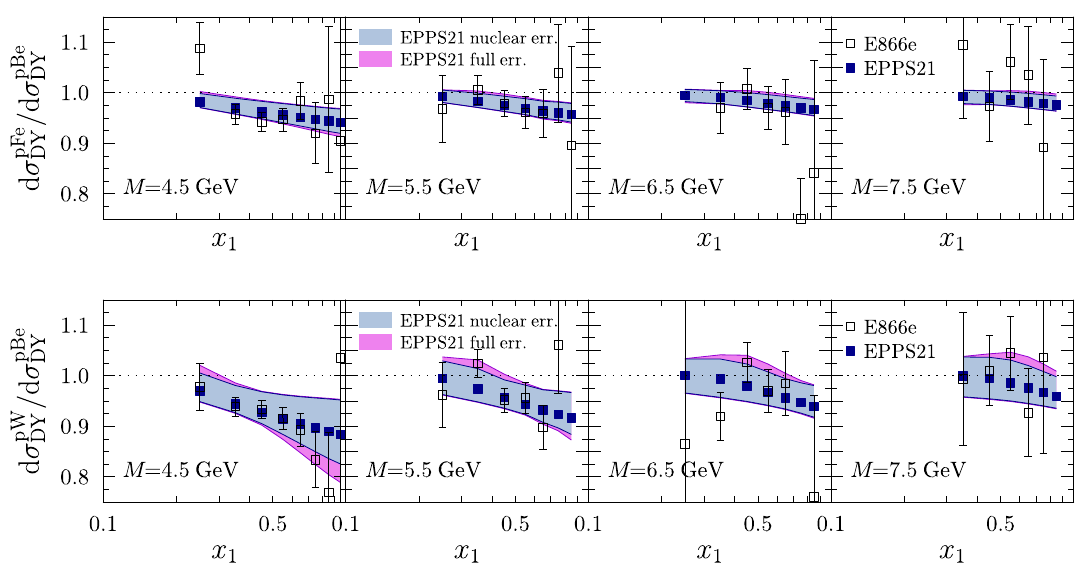
Fig. 24 Drell–Yan cross-section ratios d σ p A / d σ pBe measured by the E866 collaboration [57] compared with the EPPS21 analysis. The solid blue points show our central results, inner blue bands the nuclear uncertainties, and the purple bands the total